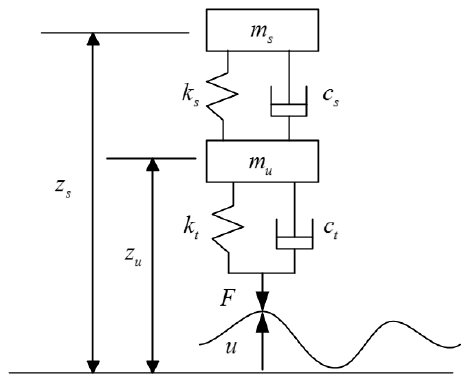
Figure 1. Quarter vehicle model with two-degree-freedom. m s is sprung mass (including vehicle body mass), m u is unsprung mass (including tire, rim and axle mass), k s , c s are suspension stiffness and damping, k t , c t are tire stiffness and damping, z s , z u are displacement of m s , m u from static balance position, u is road